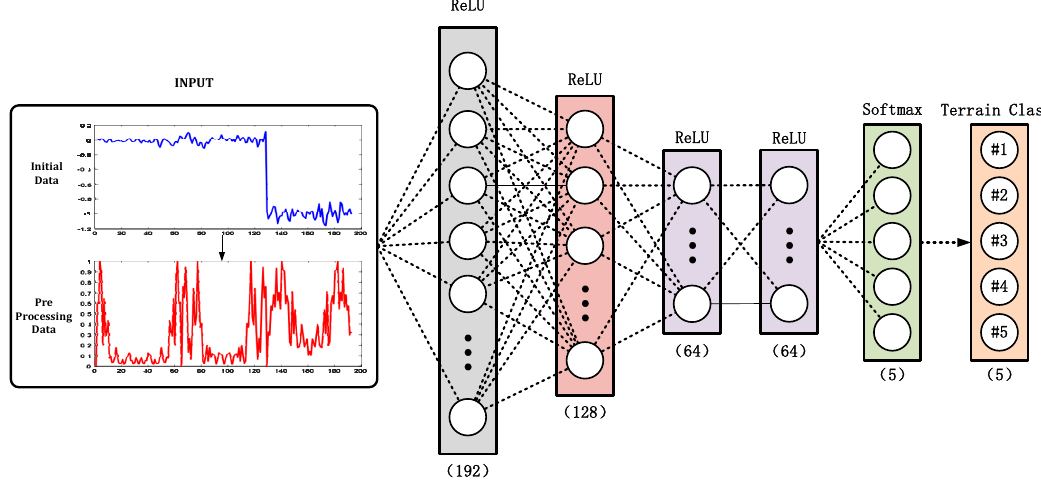
Figure 4. Multi-layer perception, deep neural network structure. ReLU: Rectified Linear Units.